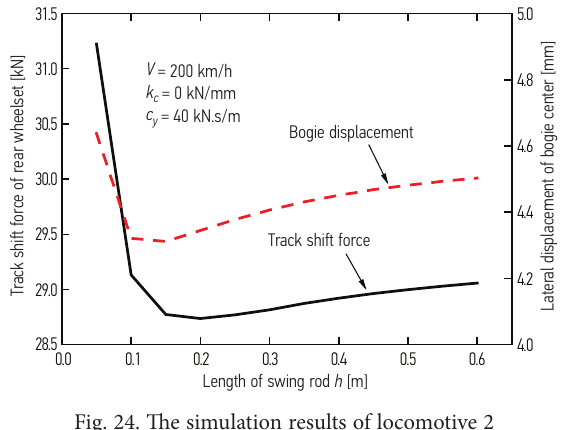
Fig. 27. The effect of length of swing rod on the non-linear critical